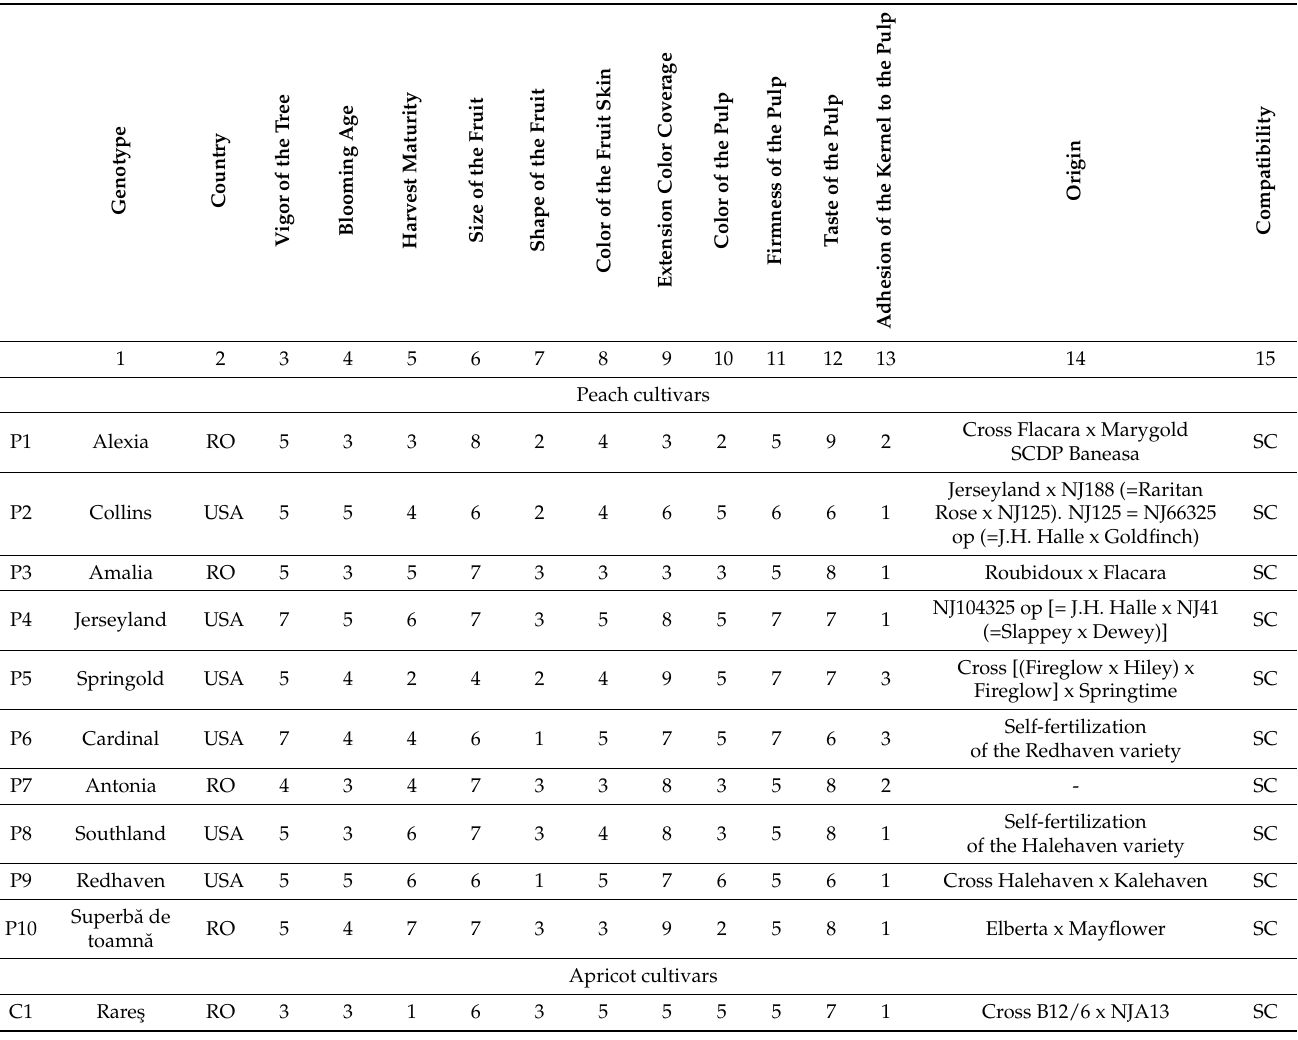
Jerseyland x NJ188 (=Raritan Rose x NJ125). NJ125 = NJ66325 op (=J.H. Halle x Goldfinch)